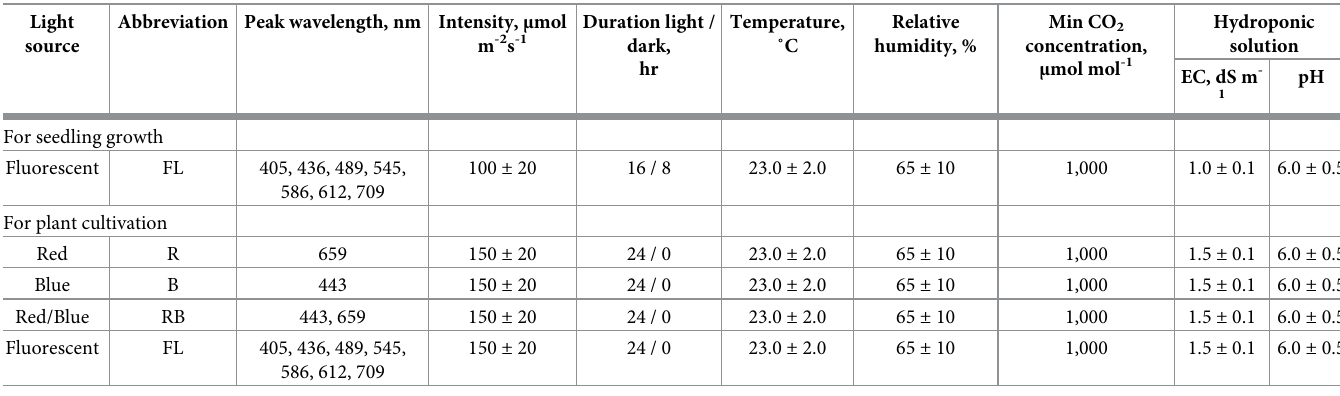
Table 1. Growth conditions of the plant materials.